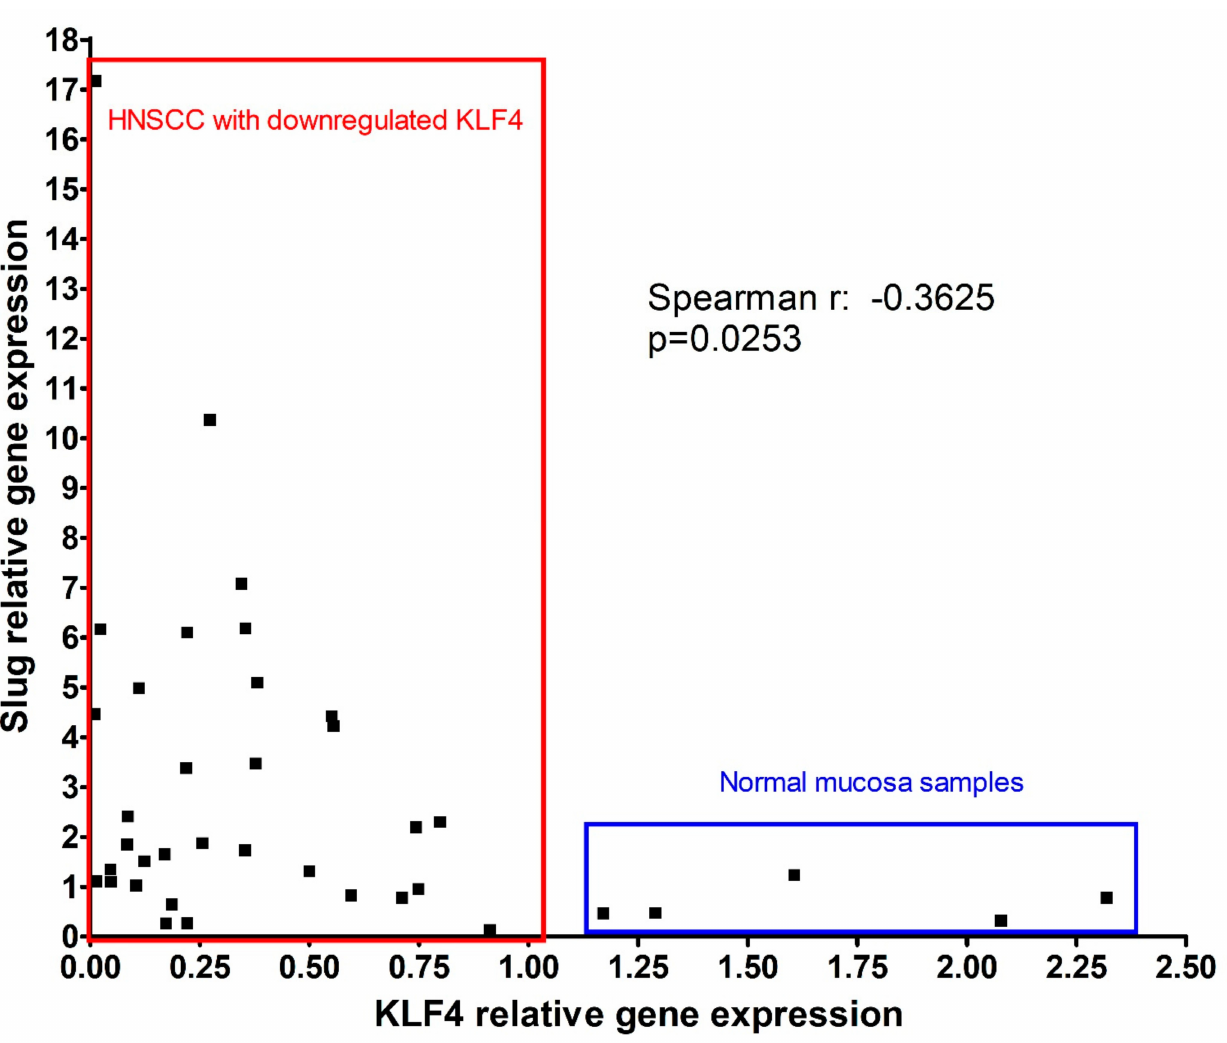
Figure 2. In HNSCC where KLF4 is reduced (red box) compared to normal mucosa from UPPP (blue box), Slug gene expression is upregulated. HNSCC with reduced KLF4 gene expression have a negative correlation between KLF4 and Slug gene